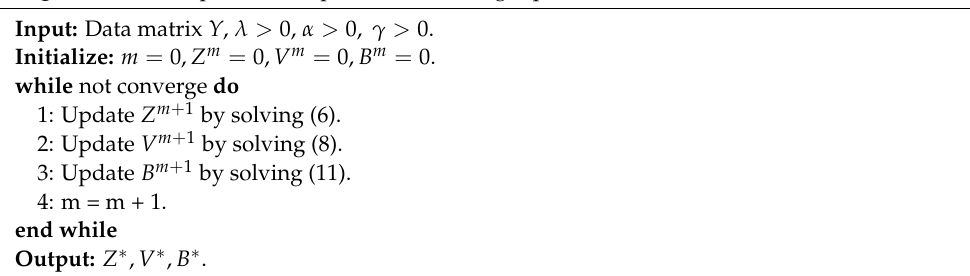
Algorithm 1 The optimization process for solving Equation